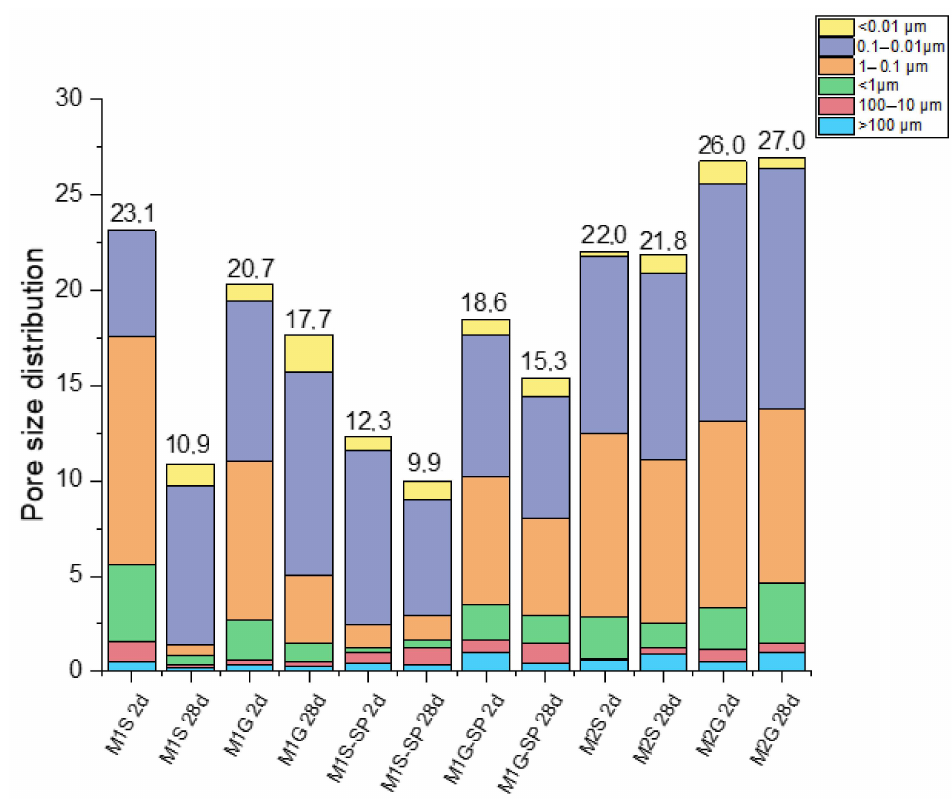
Figure 3. Mortar pore size